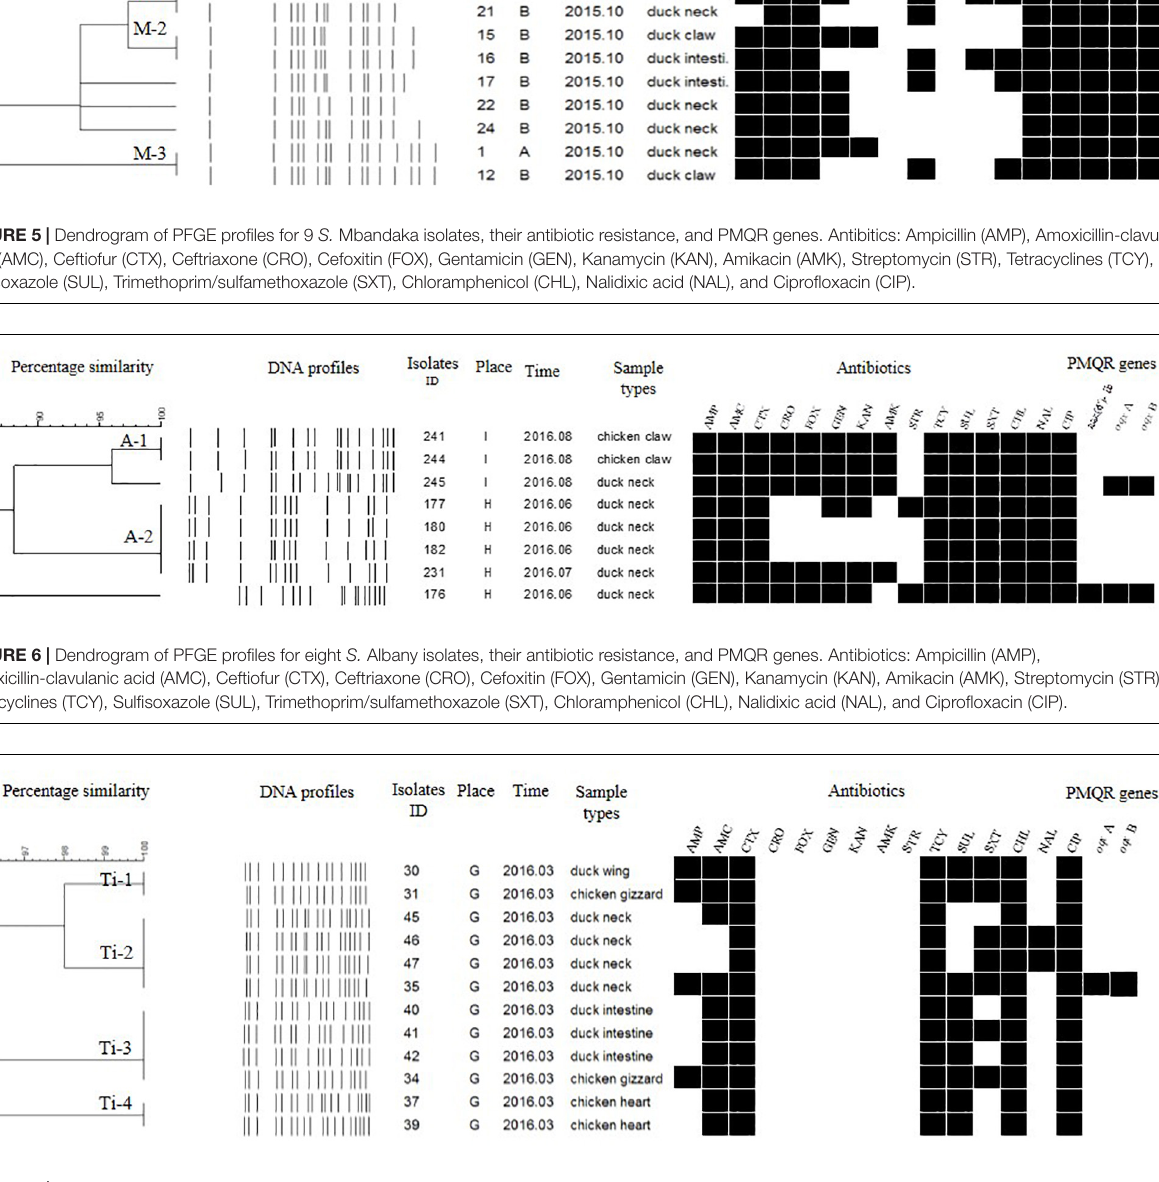
FIGURE 7 | Dendrogram of PFGE profiles for 12 S. Typhi isolates, their antibiotic resistance, and PMQR genes. Antibiotics: Ampicillin (AMP), Amoxicillin-clavulanic acid (AMC), Ceftiofur (CTX), Ceftriaxone (CRO), Cefoxitin (FOX), Gentamicin (GEN), Kanamycin (KAN), Amikacin (AMK), Streptomycin (STR), Tetracyclines (TCY), Sulfisoxazole (SUL), Trimethoprim/sulfamethoxazole (SXT), Chloramphenicol (CHL), Nalidixic acid (NAL), and Ciprofloxacin